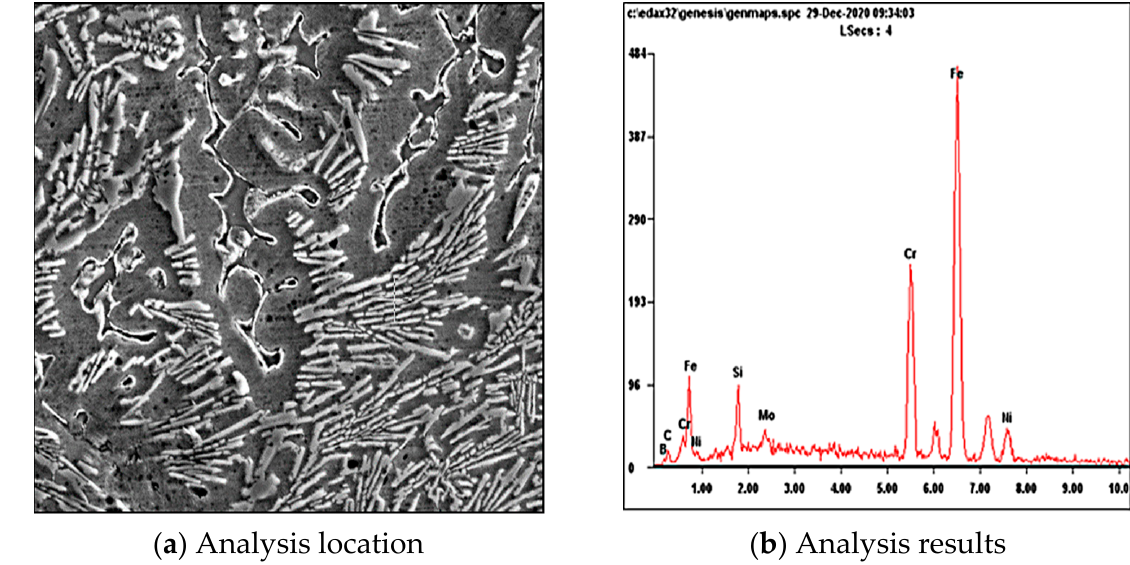
Figure 4. The microstructure of surfacing alloy with different B content.